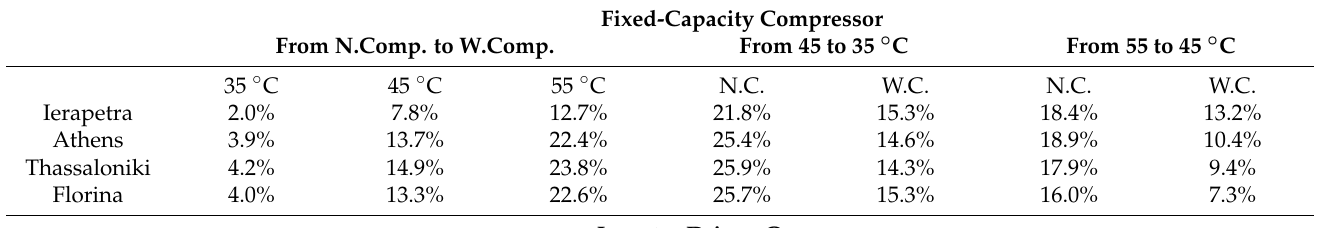
Table 8. Seasonal coefficient of performance (SCOP) increase due to decrease of the water outlet temperature (from 45 to 35 ◦ C and from 55 to 45 ◦ C) and weather